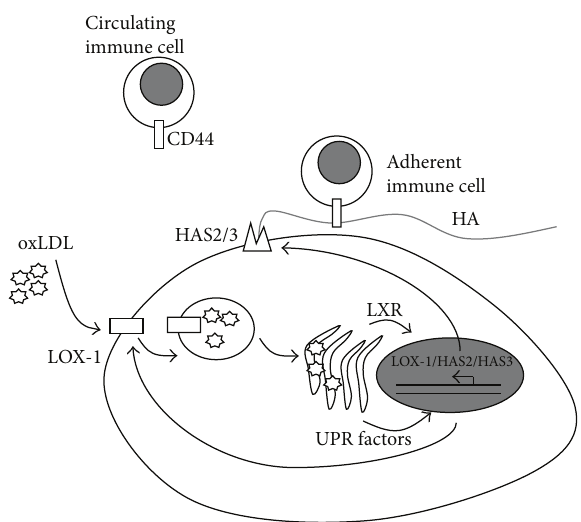
Figure 5: Schematic representation of HA metabolism in SMCs loaded with oxidized LDL (oxLDL). Nontoxic concentrations of oxLDL are driven inside the SMCs by the upregulation of the scavenger receptor LOX-1. Accumulation of oxLDL leads to ER stress with overexpression of the UPR factors CHOP and GRP78 as well as activation of the LXR sterol sensor system. One or both systems induce the overexpression in the nucleus of several genes: LOX-1, HAS2, and HAS3. The HASs are active on the plasma membrane where they synthesize HA that interacts with CD44 present on immune cells, driving their adhesion, which contributes to the inflammatory status of the atherosclerotic